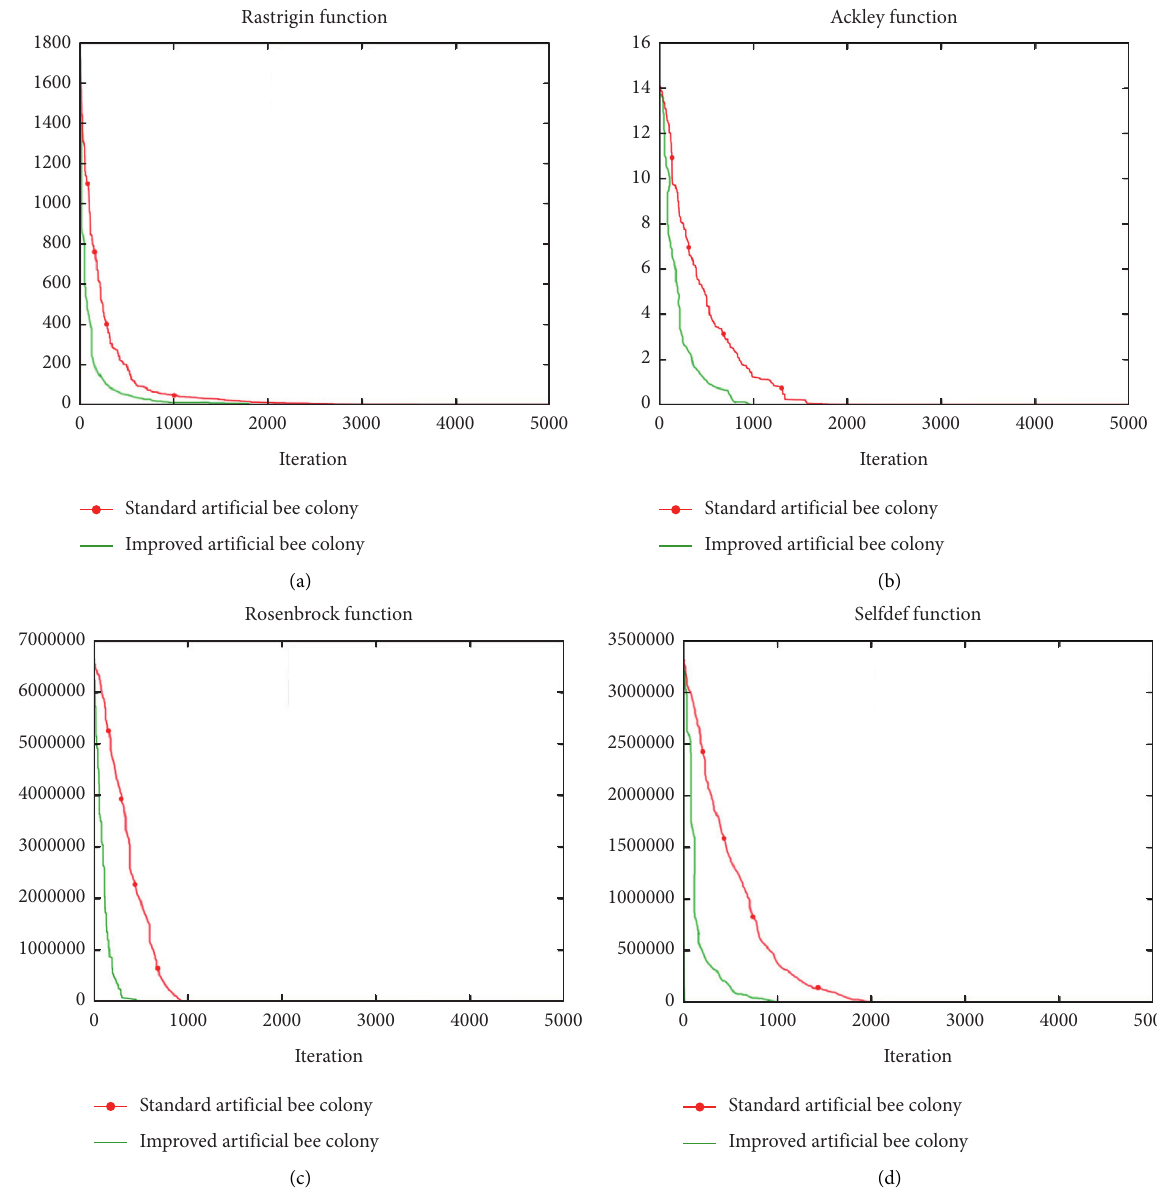
Figure 10: Convergence rate contrast curve. (a) Rastrigin function. (b) Ackley function. (c) Rosenbrock function. (d) Selfdef